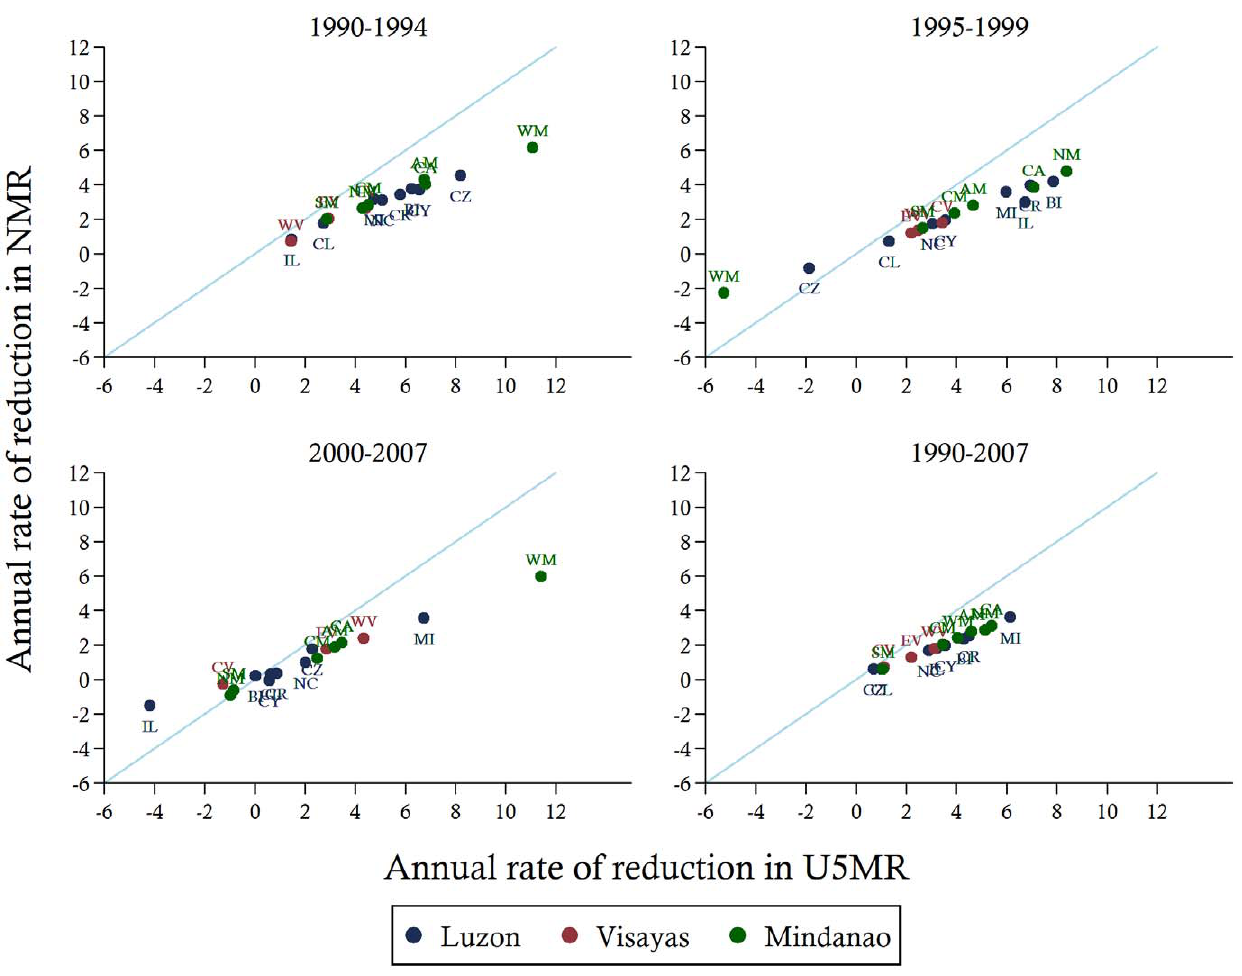
Figure 5. Annual rates of reduction in under-five vs. neonatal mortality rates over the periods 1990–1994, 1995–1999, 2000–2007, and 1990–2007 in the Philippines by regions. Notes : Data are from Demographic Health Surveys 2008. AM, Autonomous Region in Muslim Mindanao; CR, Cordillera Administrative Region; IL, Ilocoos Region; CY, Cagayan Valley; CL, Central Luzon; CZ, CALABARZON (Cavite, Laguna, Batangas, Rizal, and Quezon); BI, Bicol Region; MI, MIMAROPA (Occidental Mindoro, Oriental Mindoro, Marinduque, Romblon and Palawan); NC, National Capital Region; WV, Western Visayas; CV, Central Visayas; EV, Eastern Visayas; WM, Zamboanga Peninsula (Western Mindanao); NM, Northern Mindanao; SM, Davao Peninsula (Southern Mindanao); CM, SOCCSKSARGEN (South Cotabato, Cotabato, Sultan Kudarat, Sarangani and General Santos City); CA, Caraga Region; NMR, neonatal mortality rate; U5MR, under-five mortality rate.